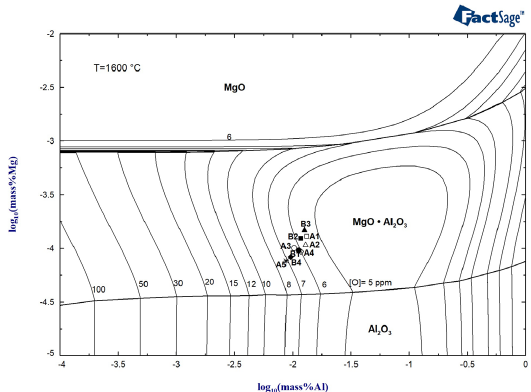
O /Al O inclusions at 2 3 2 3